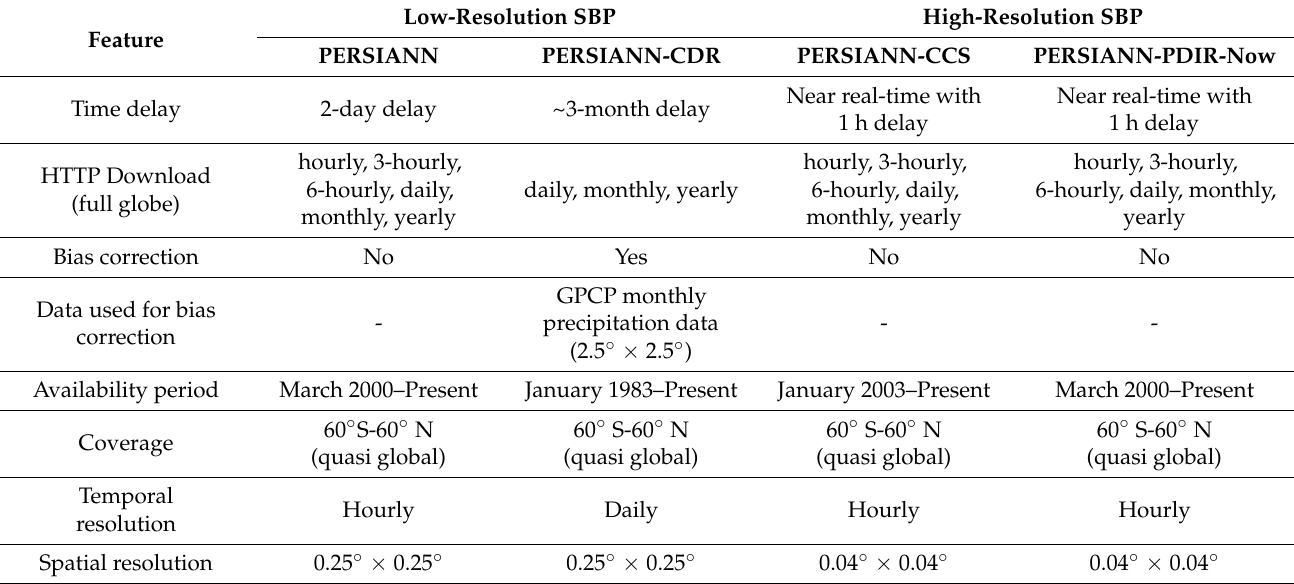
Table 1. Algorithm and basic attributes of the SBP